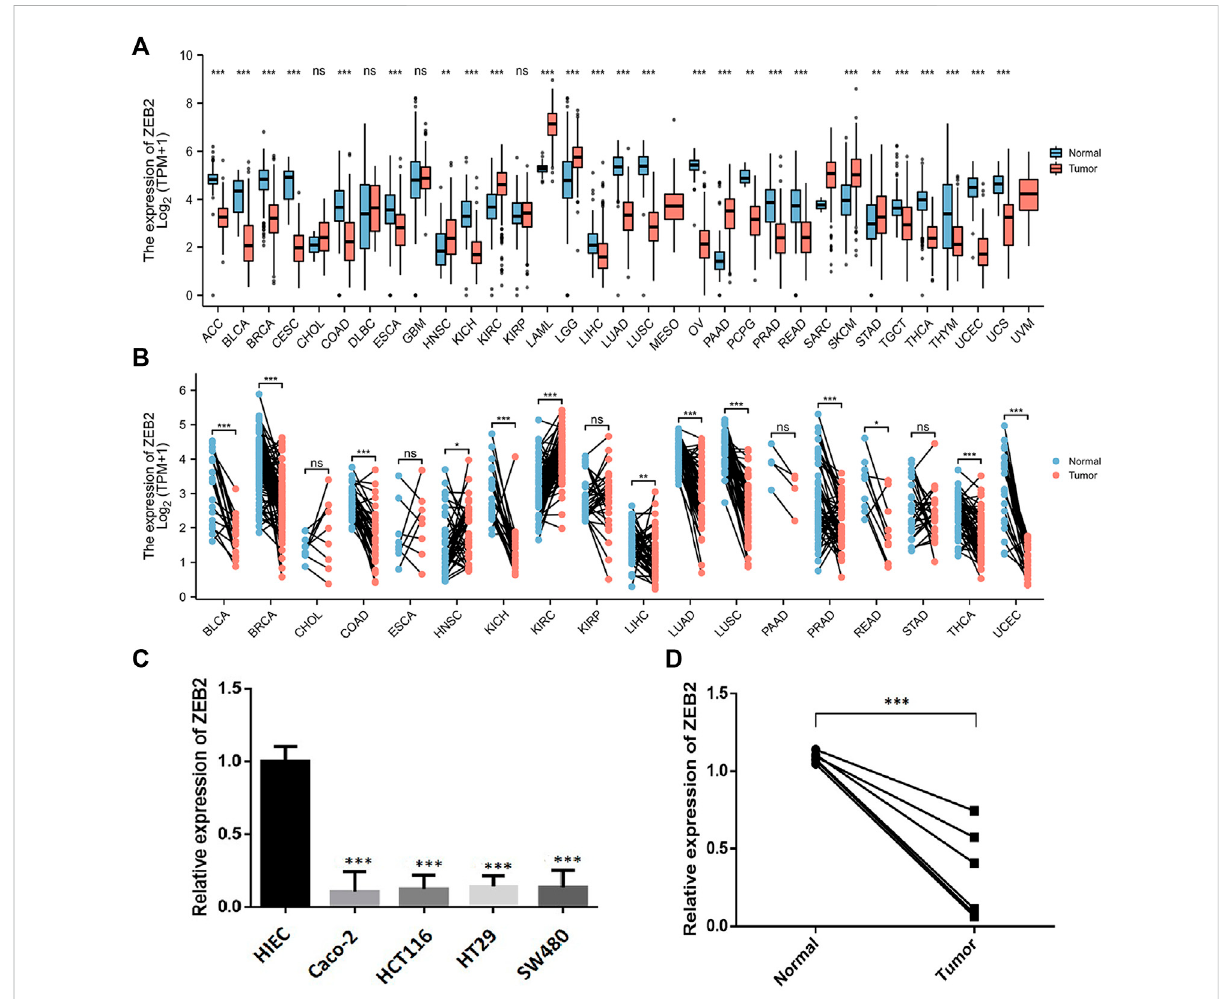
FIGURE 2 ZEB2 expression in different cancers. (A) ZEB2 expression in unpaired samples of different cancers. (B) ZEB2 expression in paired samples of different cancers. (C) Difference in the ZEB2 transcription between normal colon cells and colon cancer cell lines. (D) Difference of ZEB2 transcription between normal tissues and colon cancer